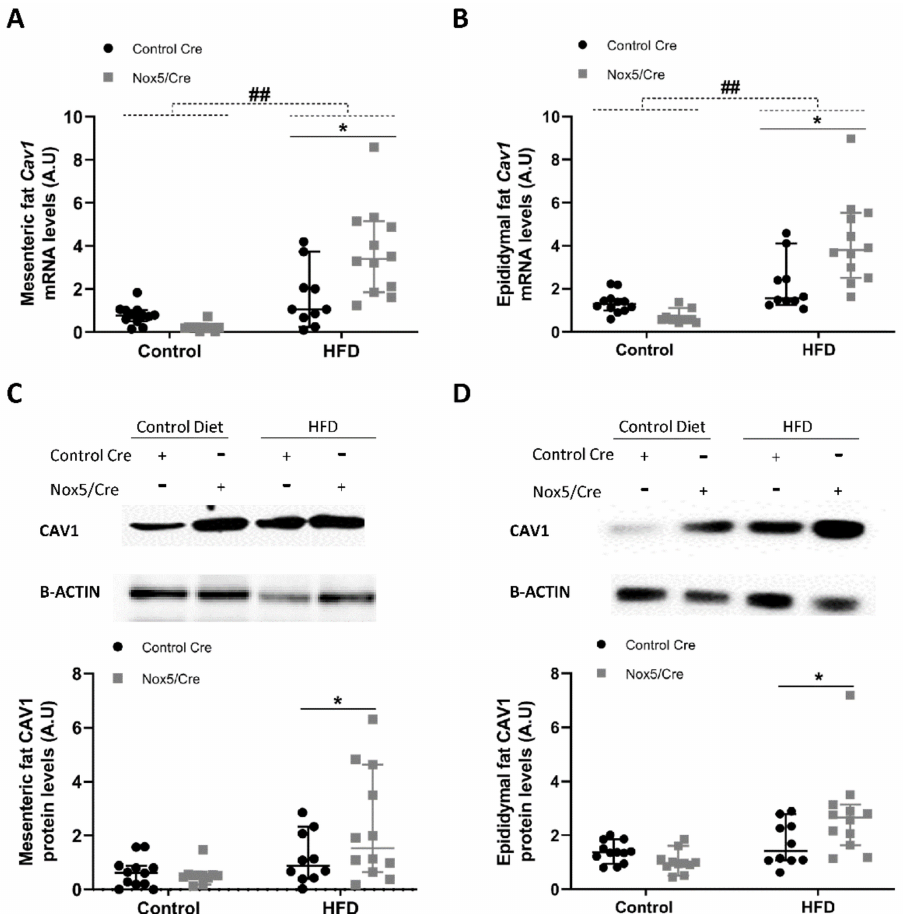
Figure 5. Endothelial NOX5 expression increased Cav1 expression in mesenteric and epididymal fat in mice fed a HFD for 10 weeks. ( A , B ) Cav1 mRNA levels in ( A ) mesenteric fat and ( B ) epididymal fat. ( C , D ) Representative Western blot and protein levels of CAV1 in total lysates of ( C ) mesenteric fat and ( D ) epididymal fat. Control diet: control Cre ( n = 12), Nox5/Cre ( n = 11); high-fat diet: control Cre ( n = 10), Nox5/Cre ( n = 12). Values are expressed as median with confidence interval. mRNA levels are relative to Gapdh . Protein levels are relative to B-ACTIN. ## p < 0.01: diet differences (dotted lines); * p < 0.05: genotype differences (solid lines). Statistical test used: Aligned Rank